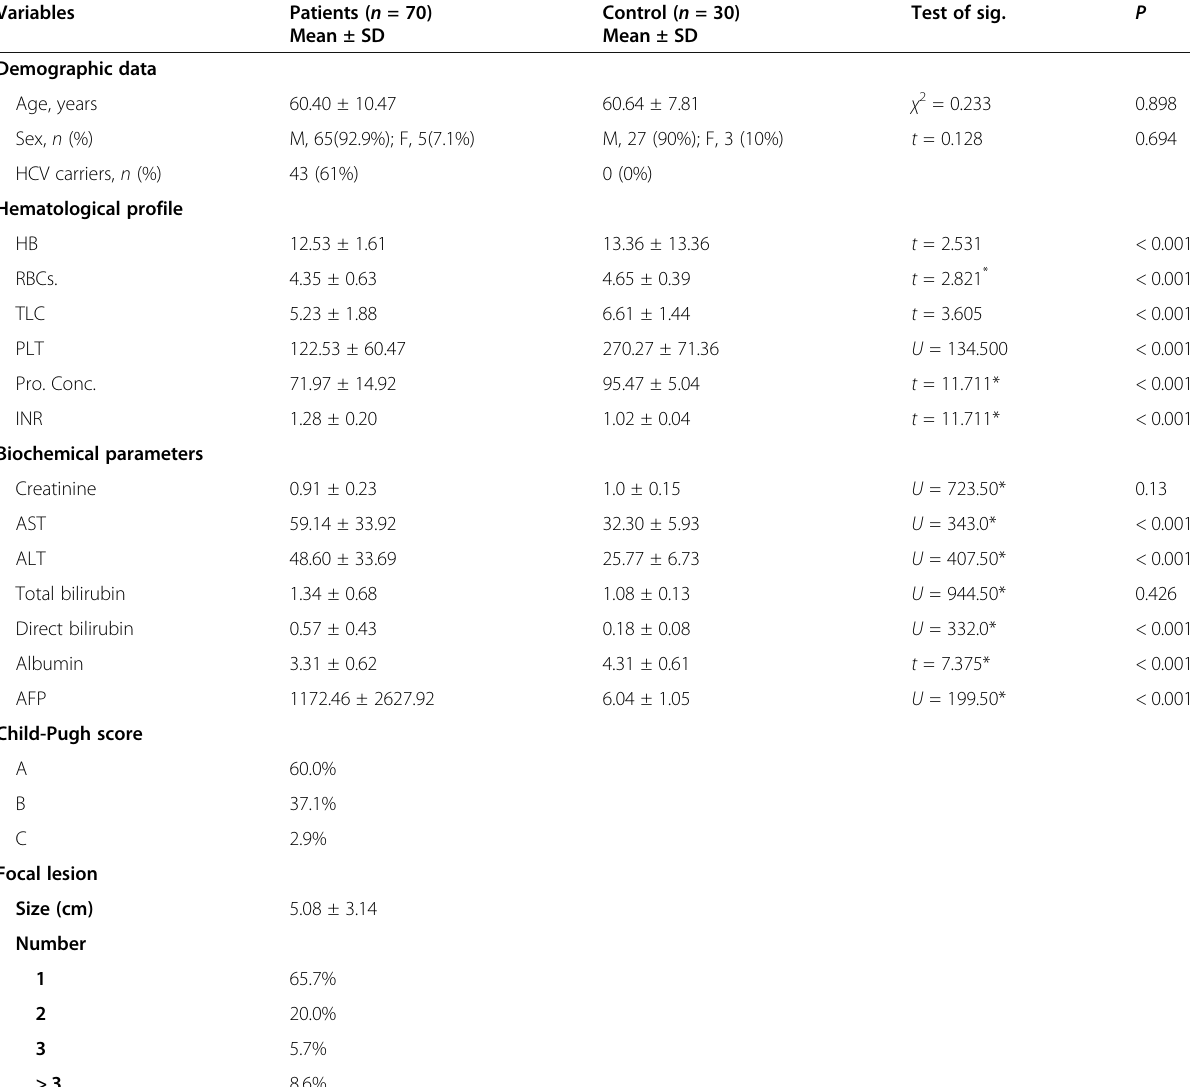
Table 1 Selected clinical and demographic characteristics of patients and controls Variables Patients ( n = 70)